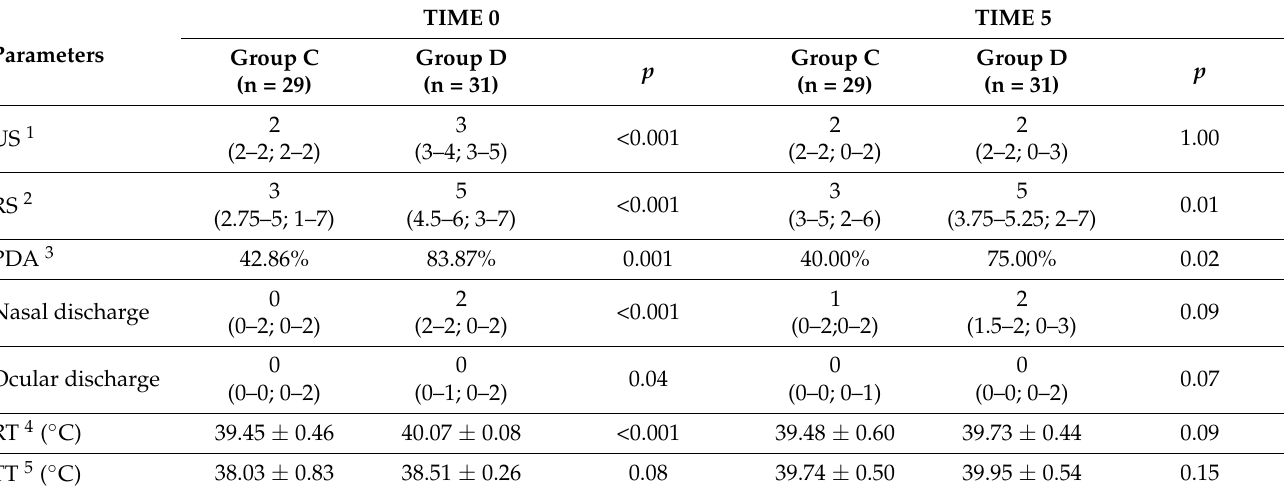
Table 1. Comparison of parameters between group C and group D at T0 (Time 0; day of restocking) and T5 (Time 5; after 21 days). Data are expressed as median (1st quartile–3rd quartile; mini- mum value–maximum value) for not normally distributed data and as mean ± SEM for normally distributed